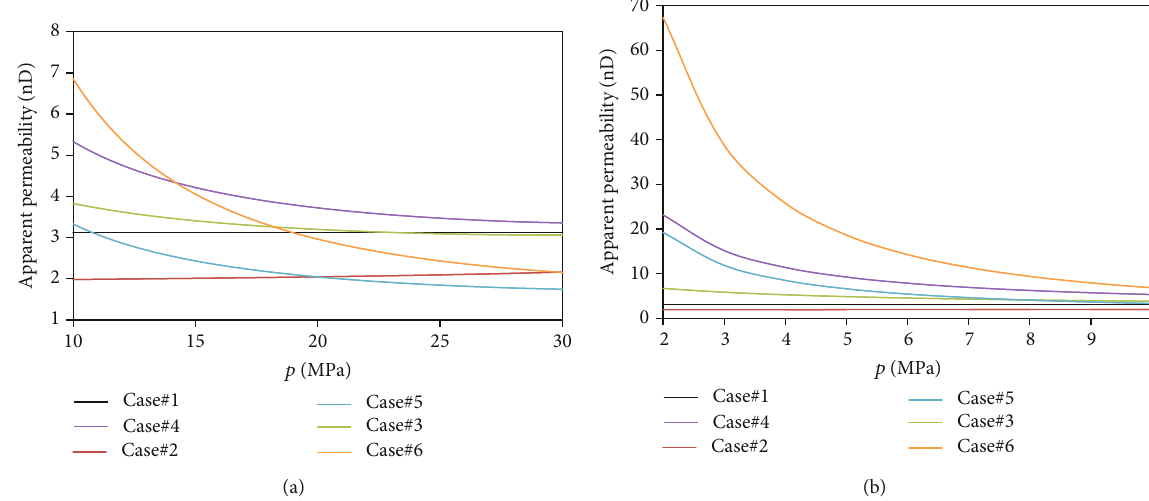
Figure 5: Relationship between apparent permeability and pore pressure considering di ff erent physics.